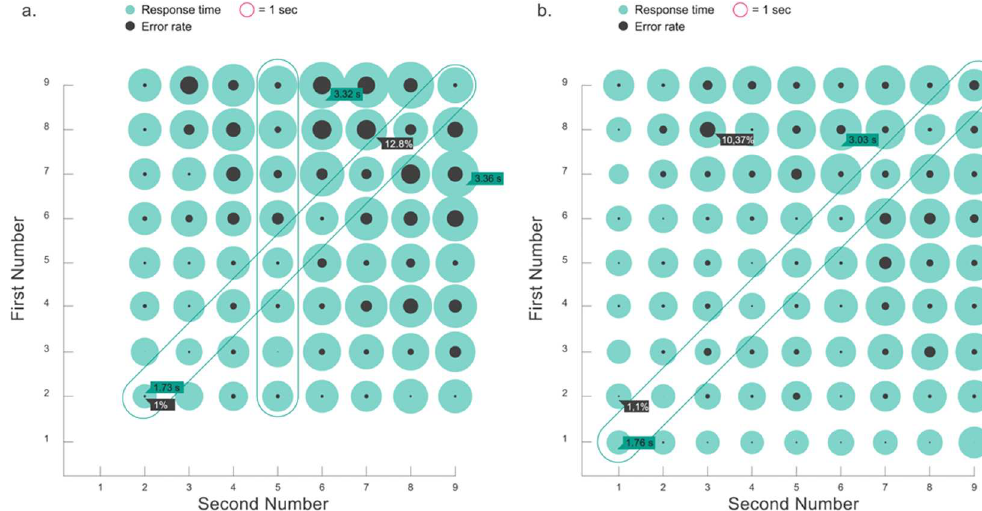
Fig 7. Averageresponse times (green) and error rates (grey) for 1-digit multiplications and additions (Fig 7A and 7B, respectively). The diameters of each circle representthe magnitude of the measure. Larger numbers are more difficult, resultingin longerRTs and larger error rates, with the exceptionof the equal-numbers multiplications and additions, and multiplications by 5, highlightedin the figure. doi:10.1371/journal.pone.0168431.g007 Table 3 the results of the mixed model linear regression. As an example, the expected error